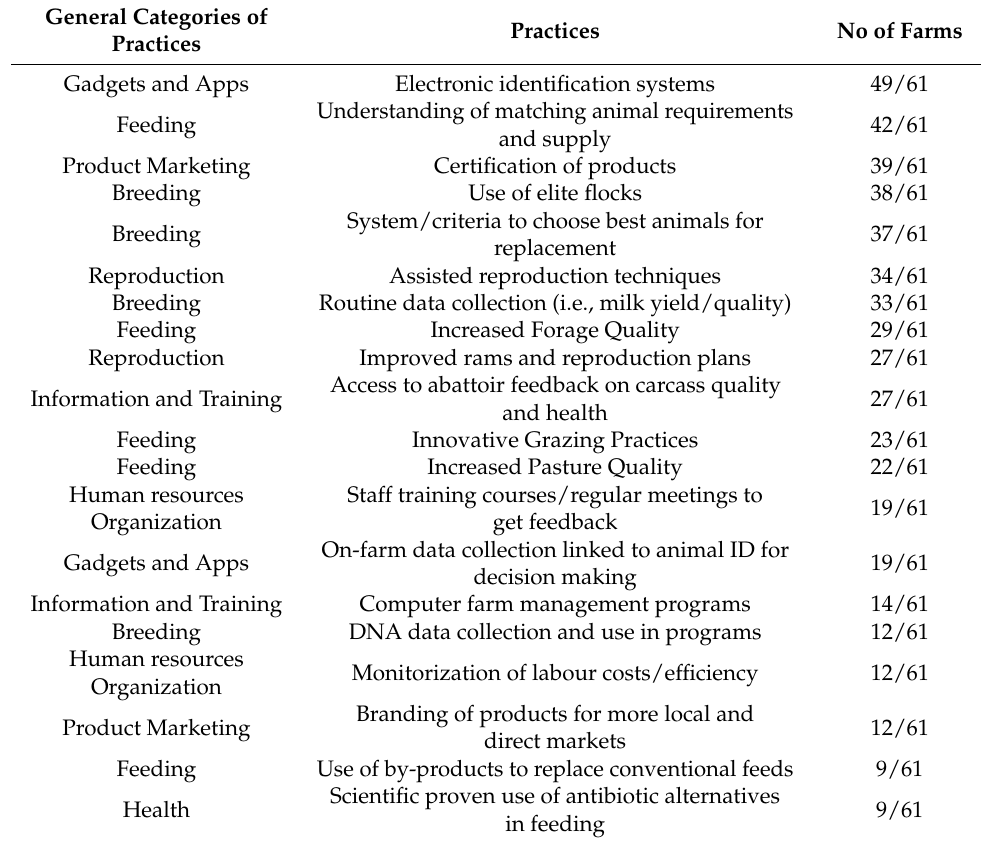
Table 6. Most observed best practices and innovations across farm